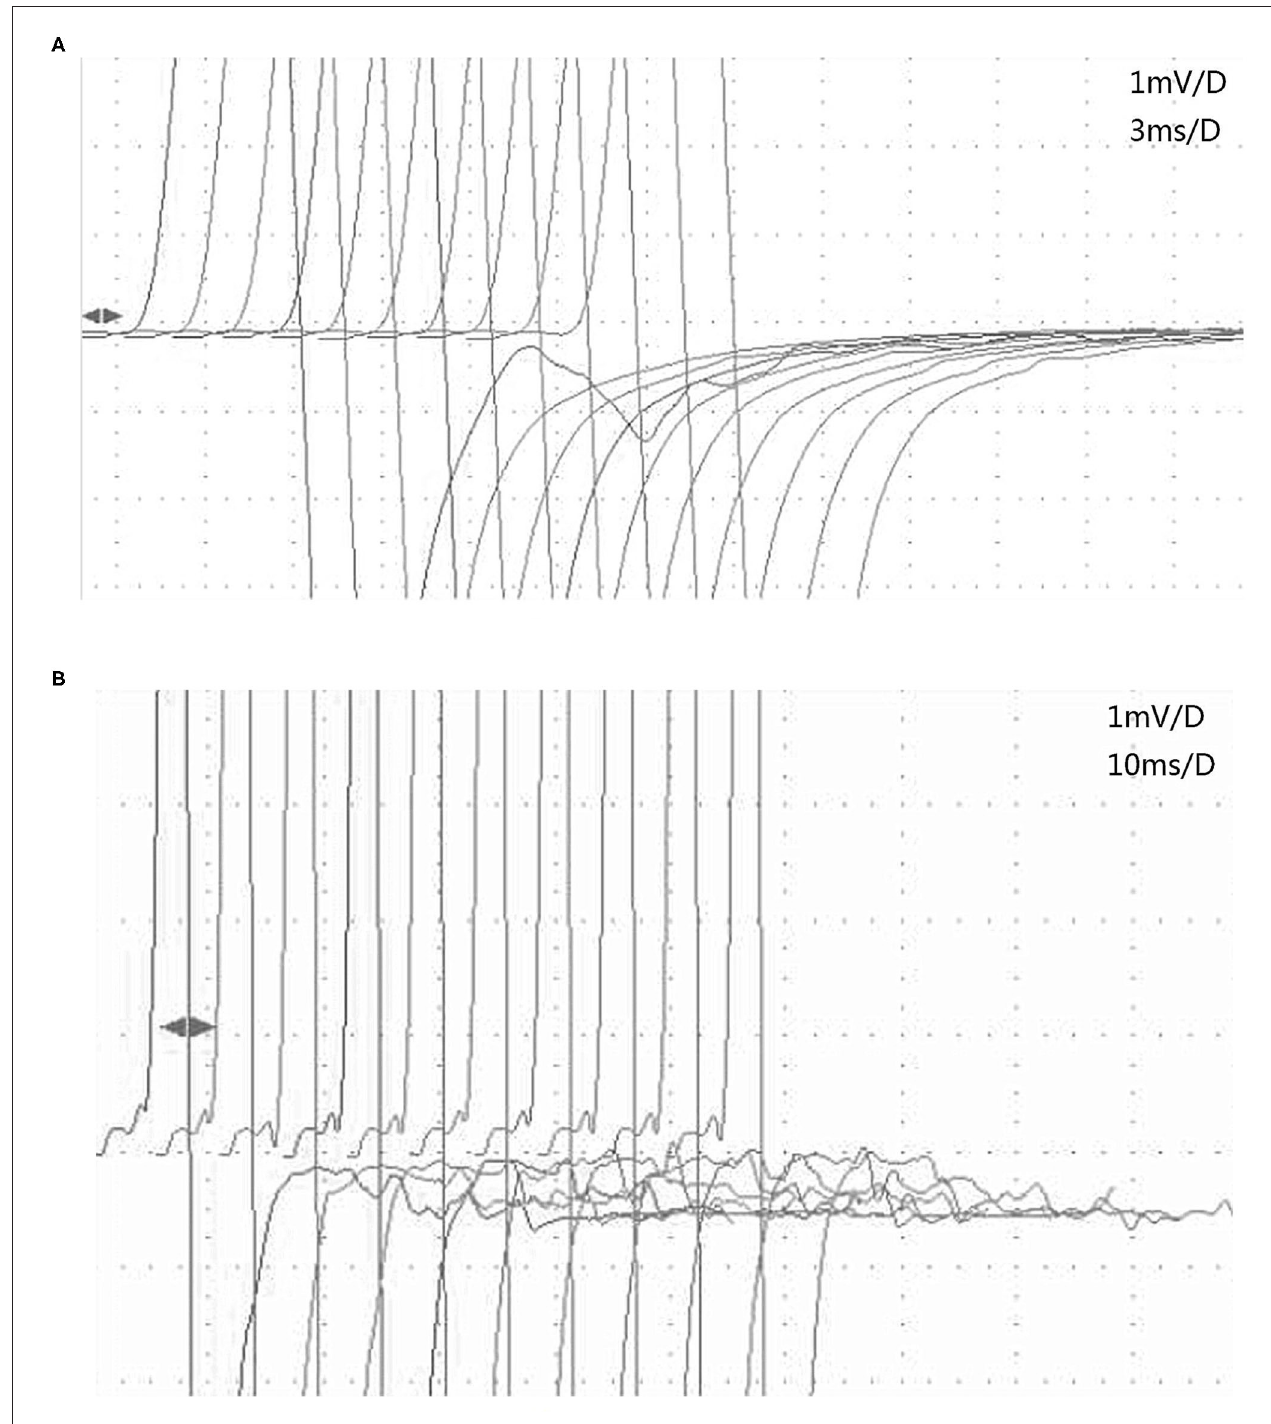
FIGURE 2 | The characteristics of afterdischarges in MuSK-MG and AchR-MG on RNS. (A) Afterdischarges appeared on the first stimulation but disappeared on the second 3-Hz RNS of the tibial nerve in patient 2 with MuSK-MG. (B) Afterdischarges continued to occur on each 3-Hz RNS of the tibial nerve in patient 6 with AchR-MG. AchR-MG, acetylcholine receptor antibody-positive myasthenia gravis; MuSK-MG, muscle-specific tyrosine kinase antibody-positive myasthenia gravis; RNS, repetitive nerve stimulation.